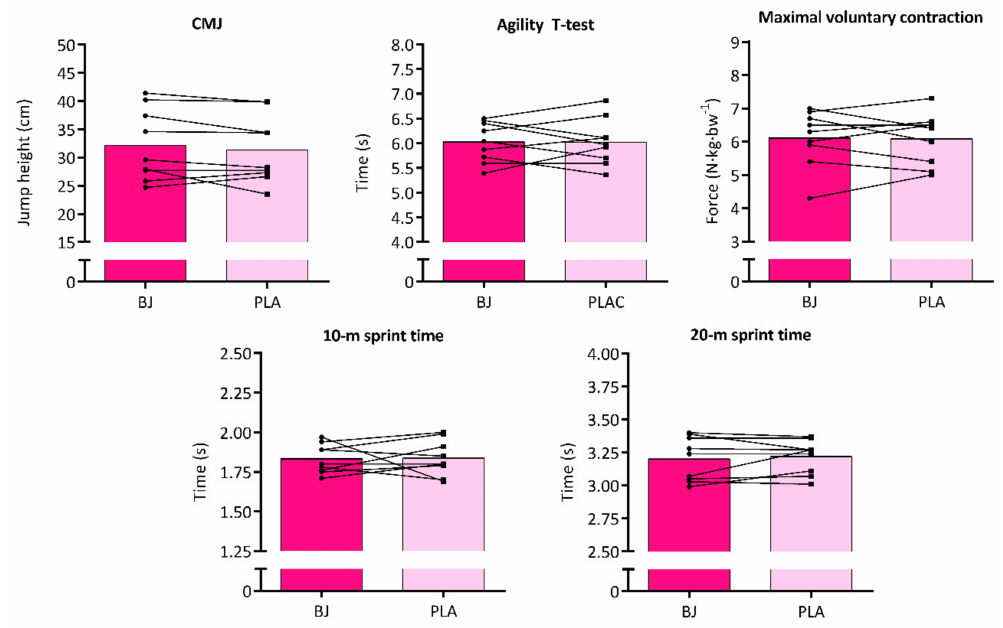
Figure 3. Neuromuscular battery test results for beetroot juice (BJ) and placebo (PLA) conditions.